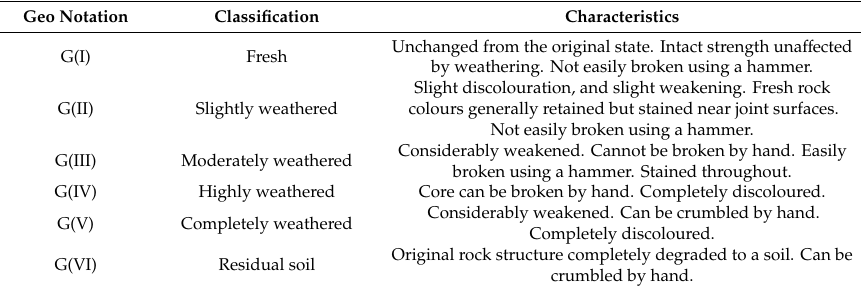
Table 2. Weathering classification for Bukit Timah granite.